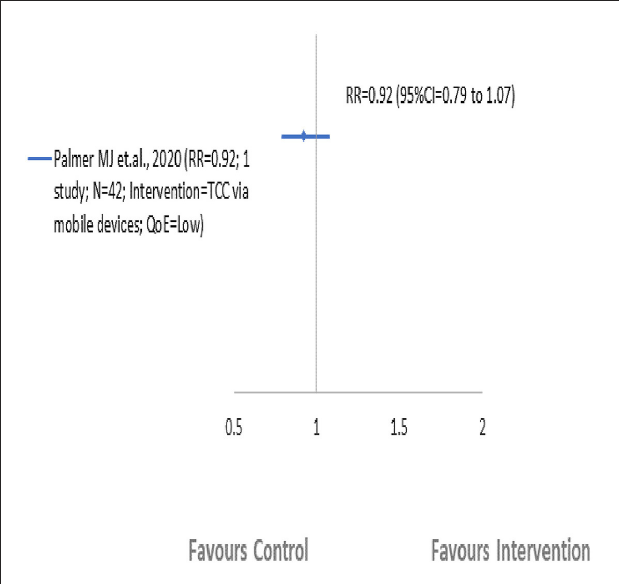
FIGURE4 Comparison 2: One BF intervention vs. other intervention. EBF, exclusive